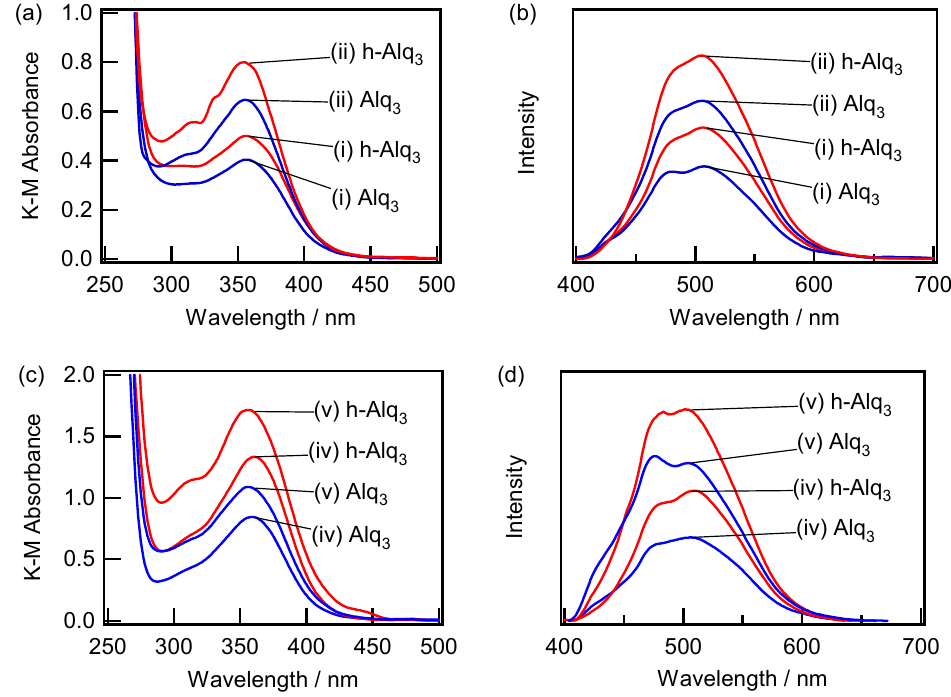
Figure 7. Absorption ( a , c ) and fluorescence ( b , d ) spectra recorded for the Alq 3 /APA and h-Alq 3 /APA samples prepared under various conditions. The excitation wavelength was 350 nm.